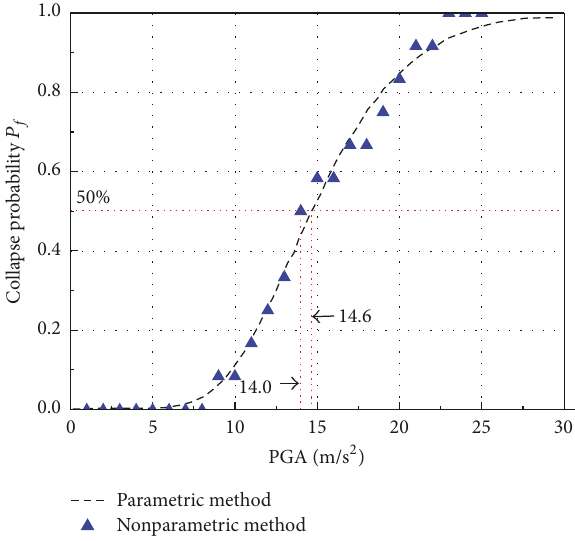
Figure 21: Collapse seismic fragility